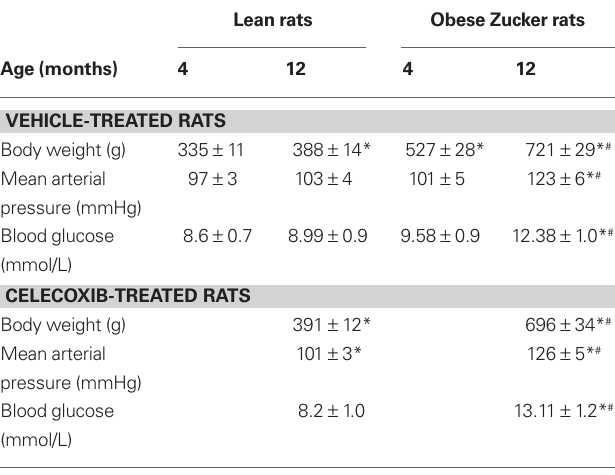
Table 1 | Body weight, mean arterial pressure, and blood glucose measured in lean and obese Zucker rats aged 4 or 12